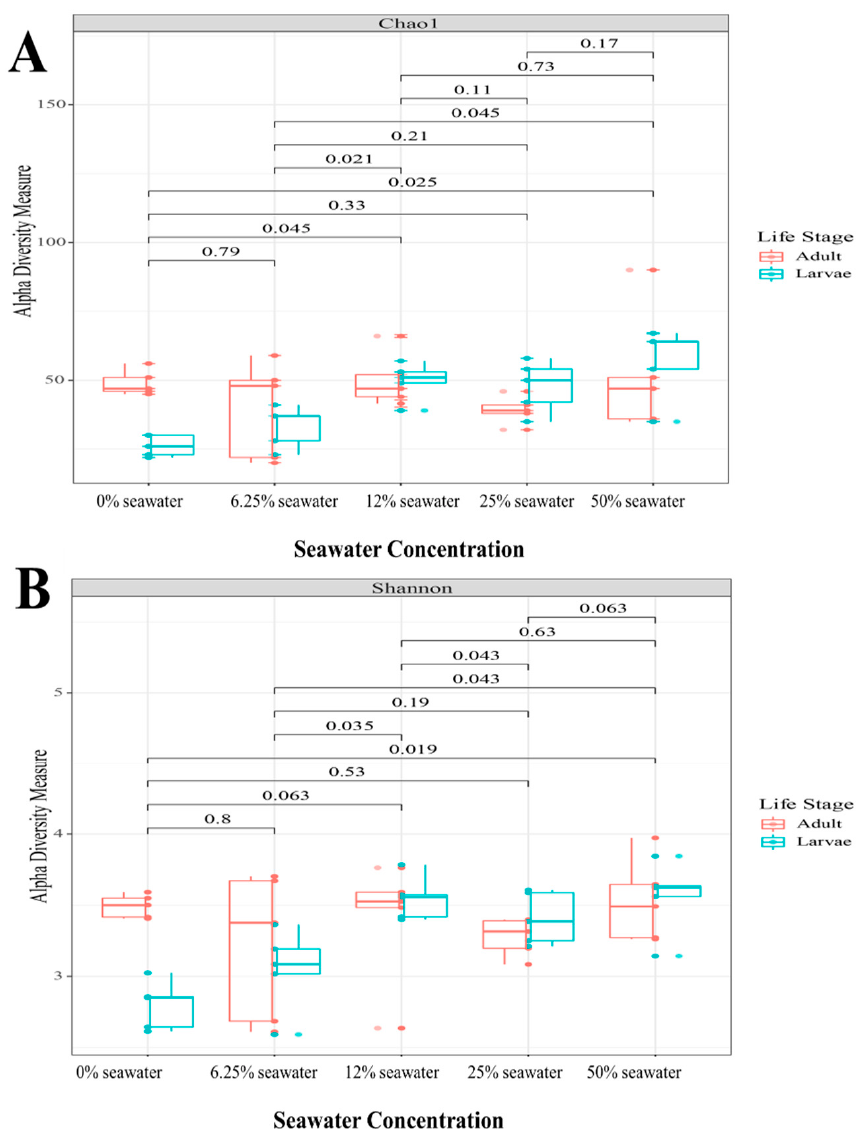
Figure 3. Alpha diversity of adult An. merus gut microbiota. ( A ) Chao1 index (species richness). ( B ) Simpson index (species evenness). Values indicate p -values from Kruskall–Wallis ANOVA. Beta diversity refers to the change in species between communities. For